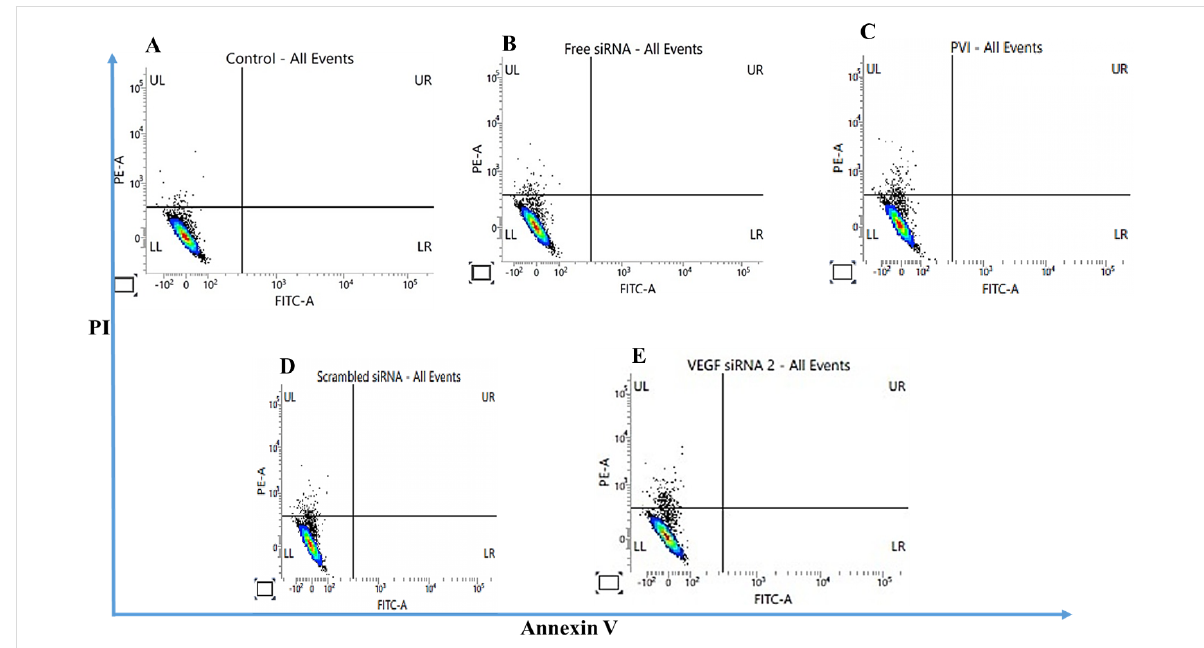
Figure 8: Flow cytometry analysis of A549 cells treated for 4 h with VEGF siRNA and analyzed 48 h after treatment. The results were compared with control and cells treated with scrambled siRNA. (A) Control; (B) free siRNA; (C) PVI; (D) scrambled siRNA; (E) VEGF siRNA. Cells were stained using FITC-conjugated Annexin V and propidium iodide (PI).